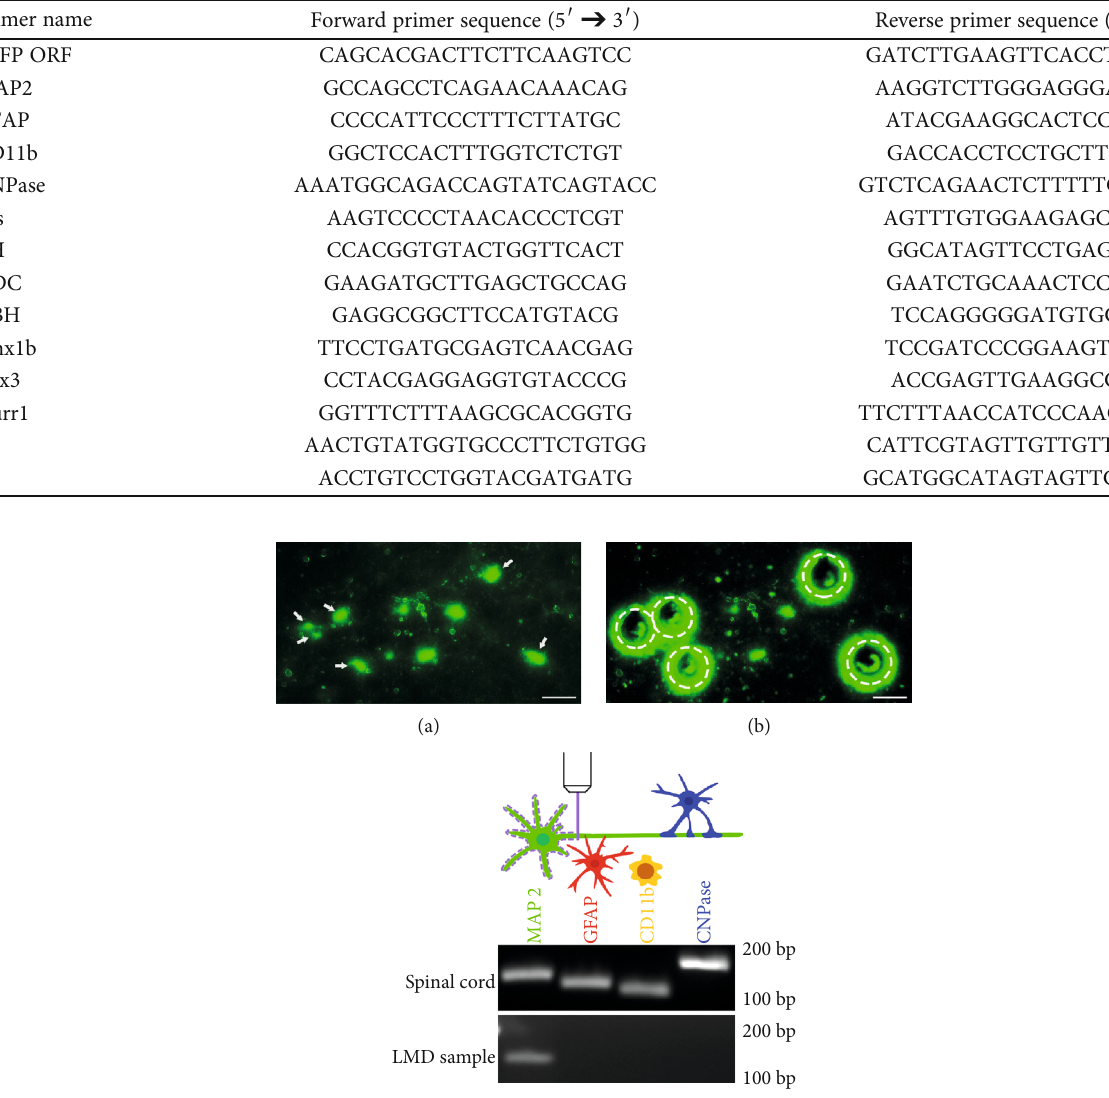
Table 1: Primers used in this study.